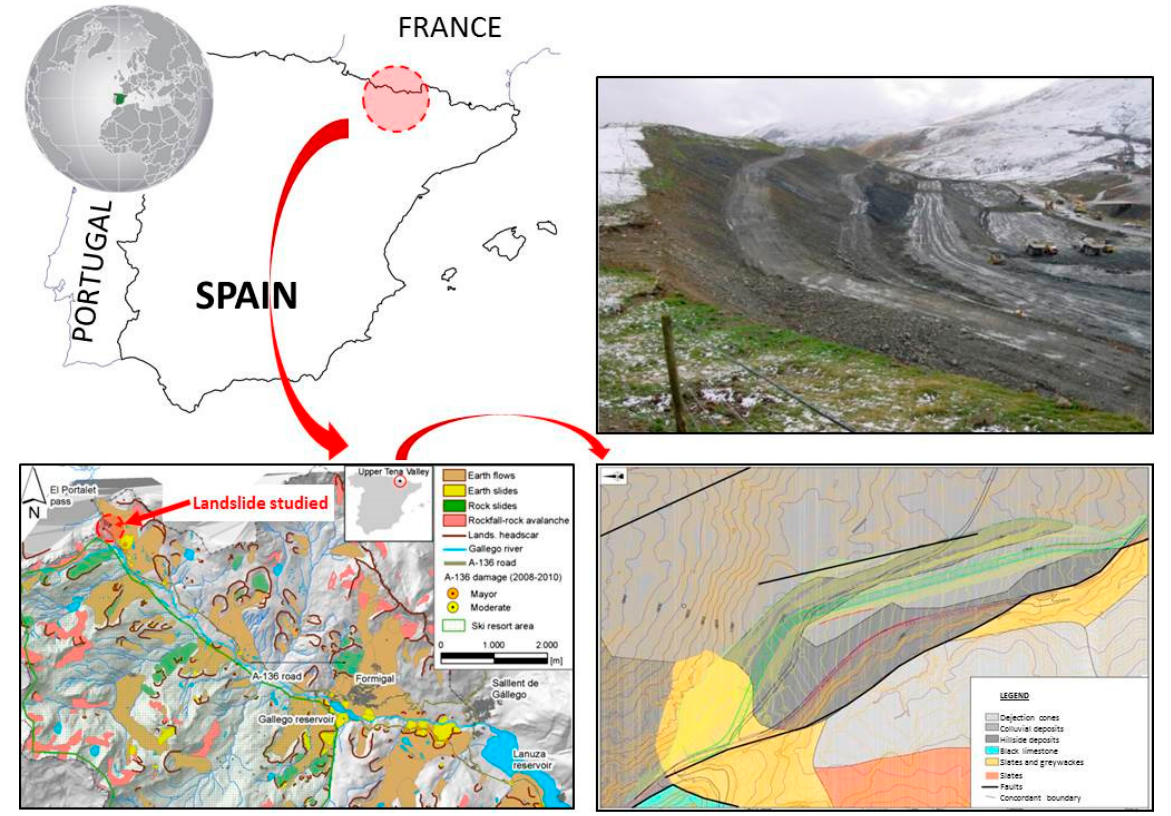
Figure 1. Geographical and geological setting of the area under study in the Central Spanish Pyrenees and view of the parking excavation works (note: bottom left image modified from [22]).